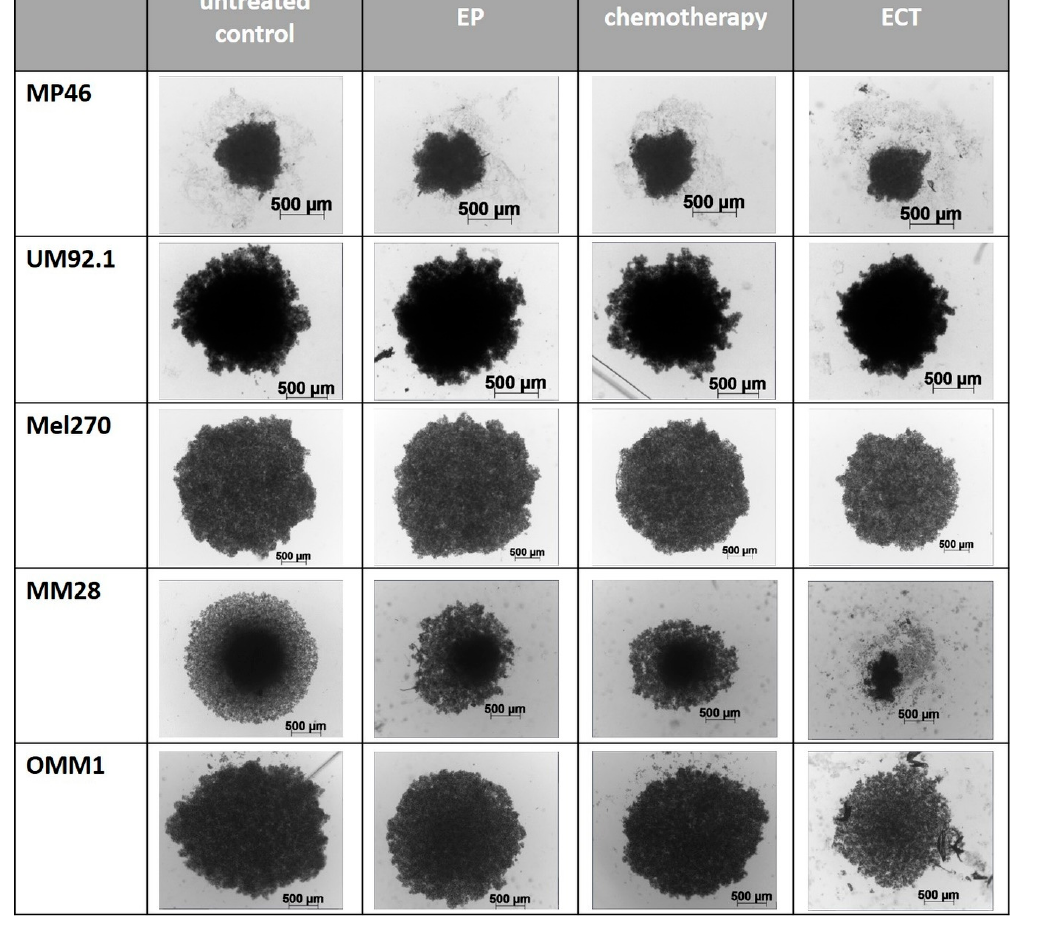
Figure 2. Representative images of spheroids from primary UM cell lines (MP46, 92.1, Mel270) and metastatic UM cell lines (MM28, OMM1) after electrochemotherapy (ECT) compared to electroporation alone (EP), chemotherapy using bleomycin (2.5 µg/mL) alone and untreated spheroids at day seven following treatment. Scale bar = 500 µm.